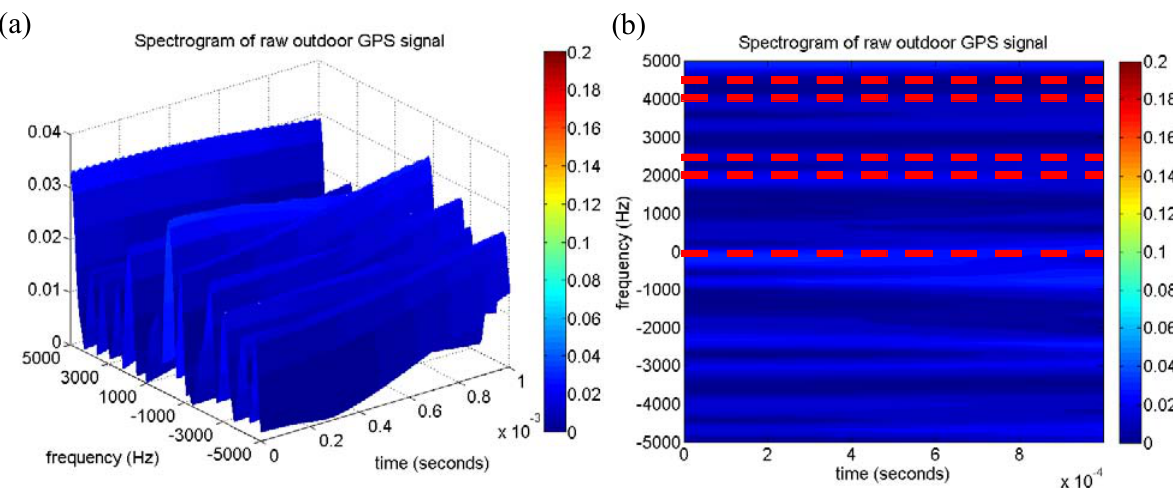
Figure 7. (a) The spectrogram of the raw outdoor GPS signal by using the time-frequency tool. (b) The top view of (a), several continuous waves could be observed in the time- frequency